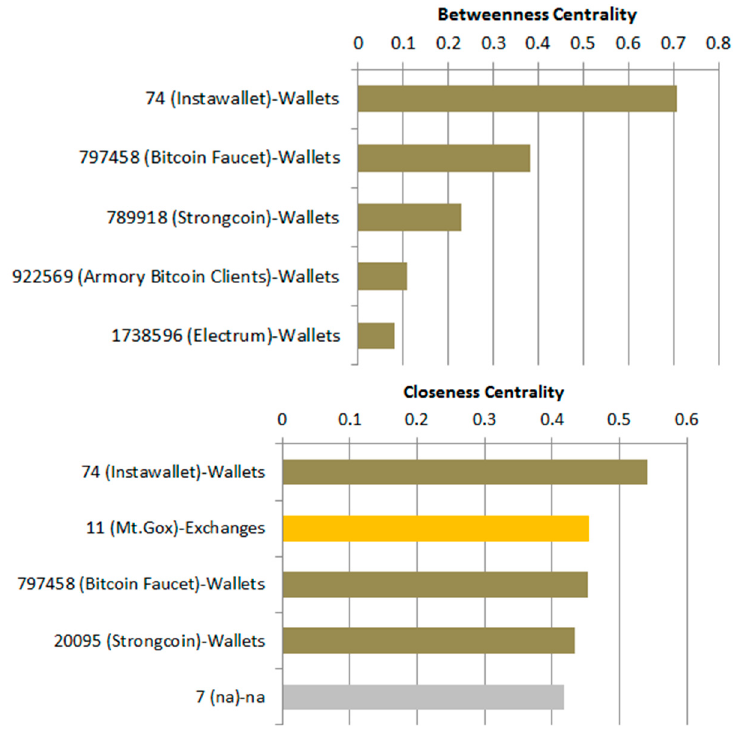
Figure 32. Betweenness and Closeness Centrality for the Wallets Business.